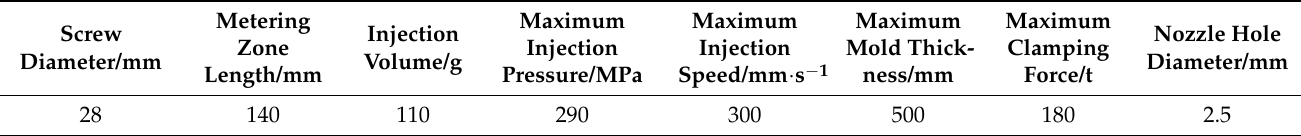
Table 6. Parameters of the injection molding machine.